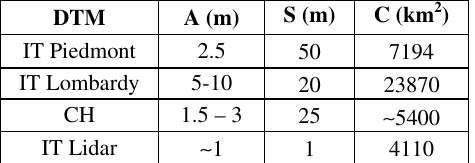
Table 2. The available data. A: nominal vertical accuracy. S: spatial resolution. C: covered area within the Helidem